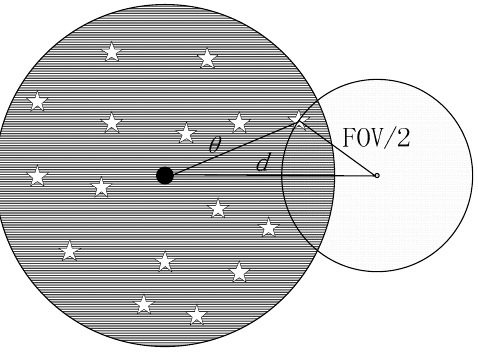
Figure 5. Necessary condition for stars to enter the FOV. The dark gray area represents sub-catalog, and the light gray area represents FOV.